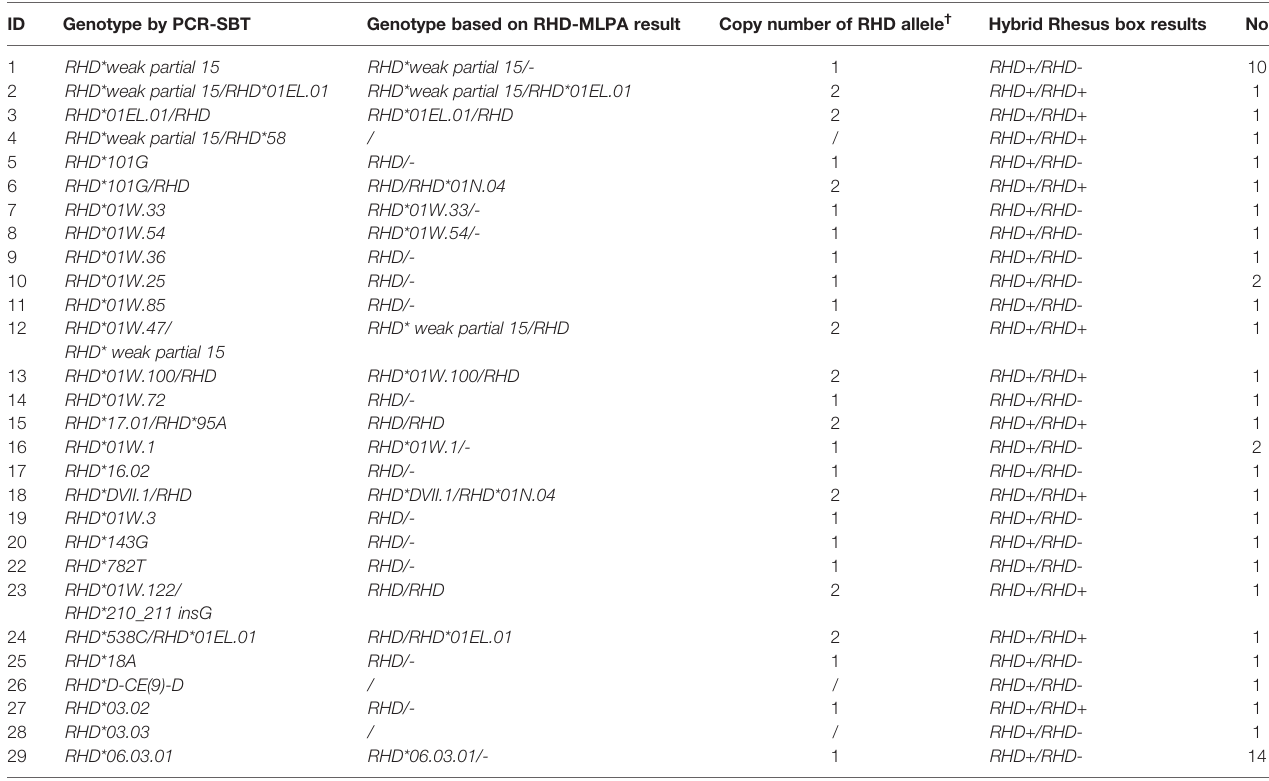
TABLE 1 | Genotype results and the copy number determination using different assays in the Chinese RhD variants.